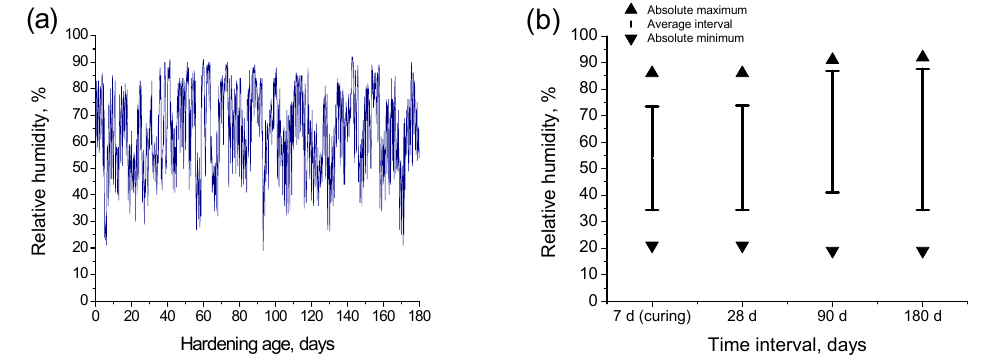
Figure 3. ( a ) Relative humidity registered during the exposure period; ( b ) Absolute maximum, absolute minimum and interval of average relatives humidity at which the samples were exposed during the seven-day curing period and for those samples tested at 28, 90, and 180 days respectively.